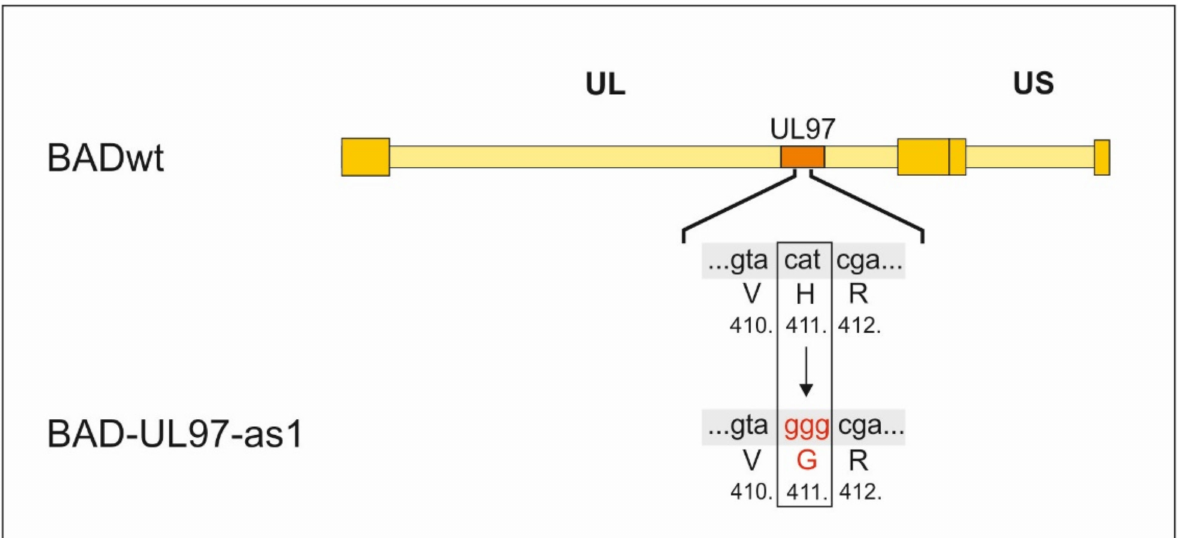
Figure 1. Construction of BAD-UL97-as1. The triplet cat coding for histidin on position 411 within the UL97 gene was replaced by ggg coding for glycin using the BAC recombination technique described in